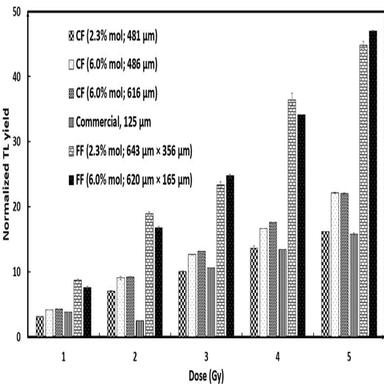
The sensitivity of FGDOFs and commercial optical fibres for 12 MeV electrons.